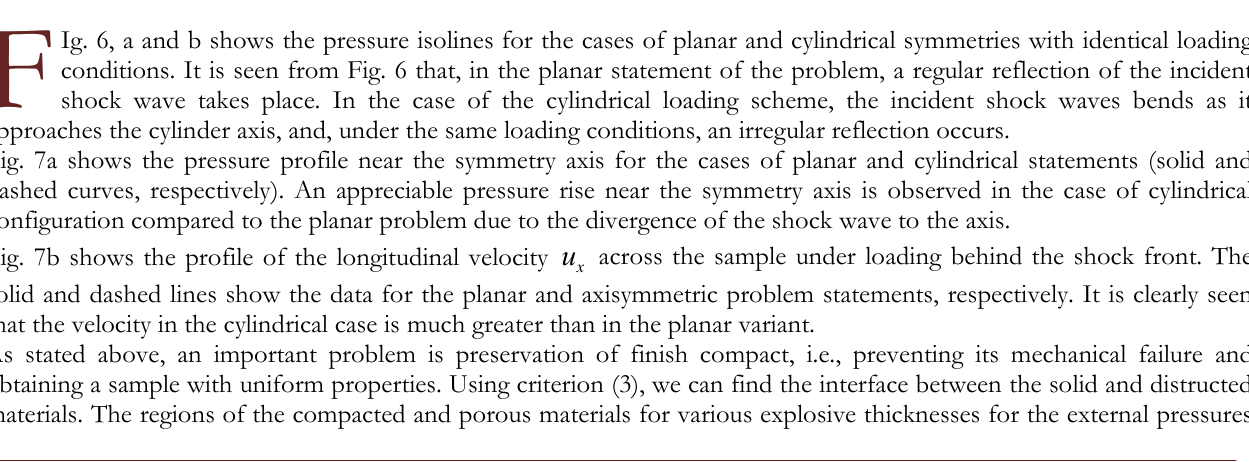
u across the sample under loading behind the shock front. The x solid and dashed lines show the data for the planar and axisymmetric problem statements, respectively. It is clearly seen that the velocity in the cylindrical case is much greater than in the planar